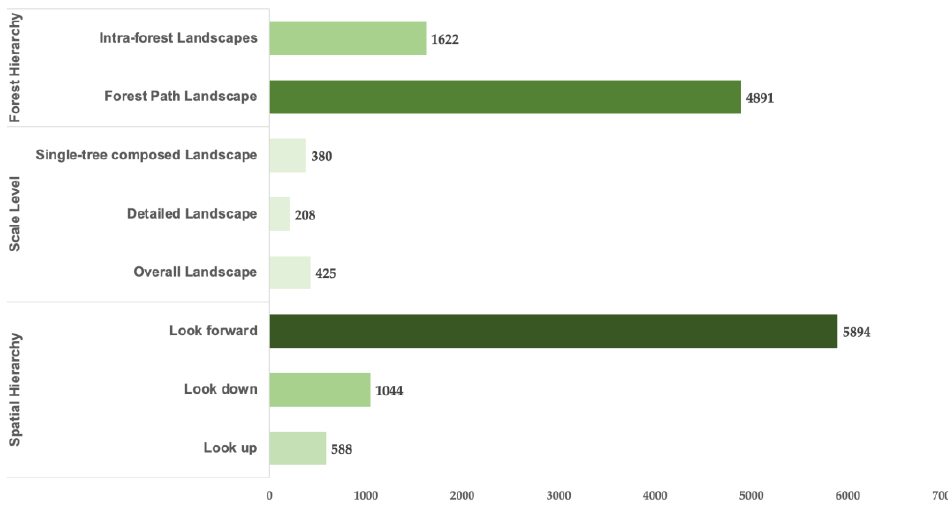
Figure 7. Deep Learning Result Graph. Table 1. High-frequency adjective of related images (more than one thousand).